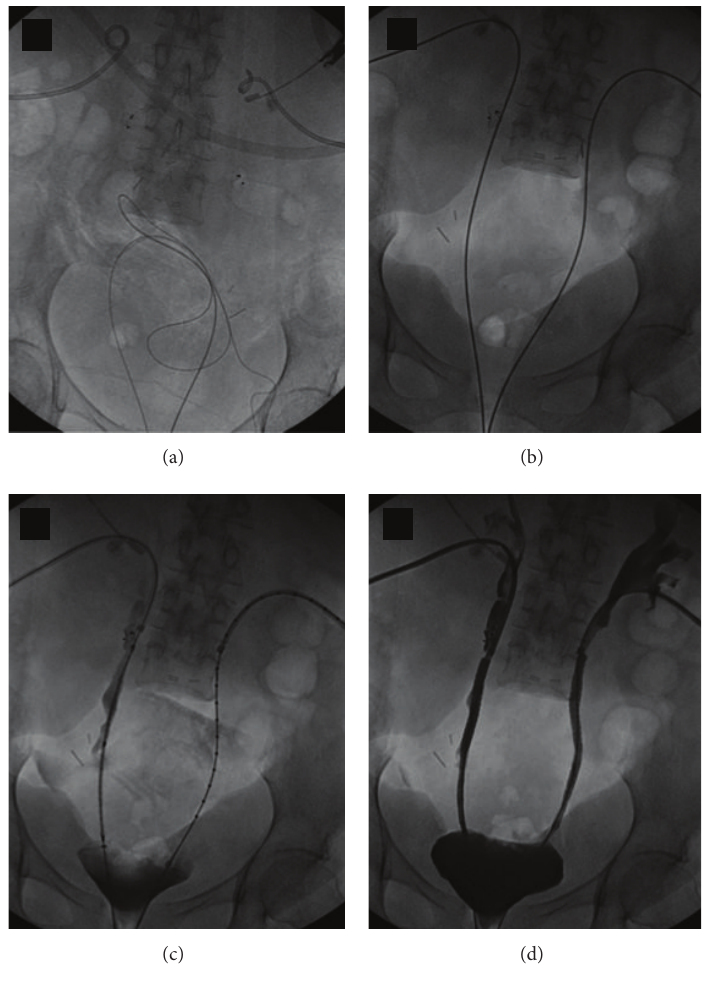
Figure 3: Rendez-vous procedure for installing the PTFE nitinol